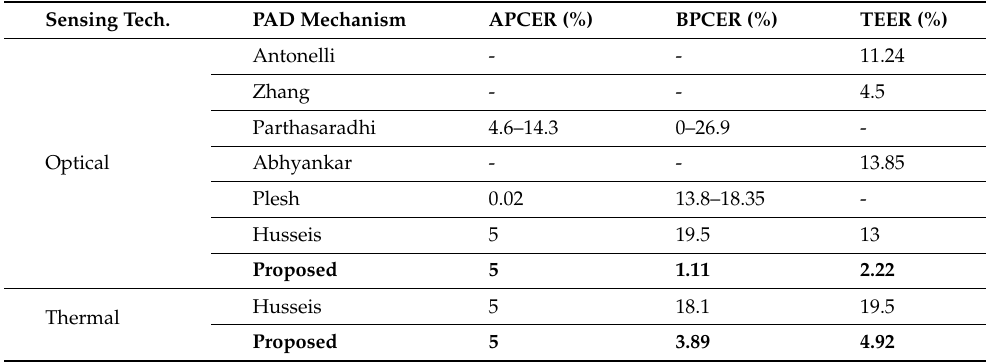
Table 10. Performance comparison with the SoA dynamic PAD